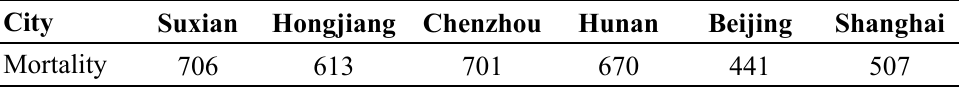
Table 3. Crude mortality in different regions in 2010 (per 100,000).